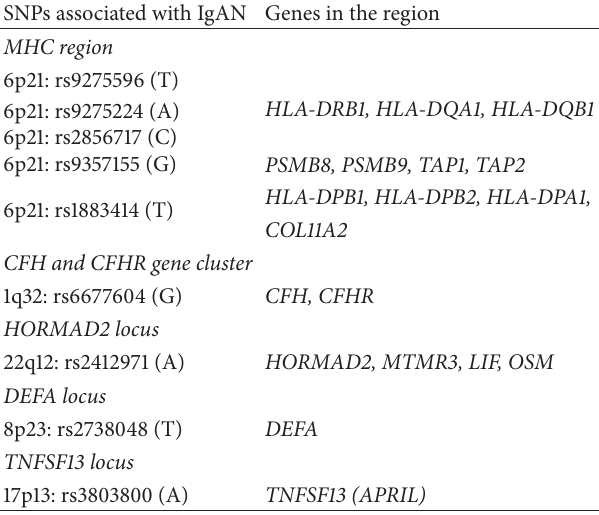
Table 1: Susceptibility loci for IgAN from multiple GWAS [35–40]. SNPs associated with IgAN Genes in the region MHC